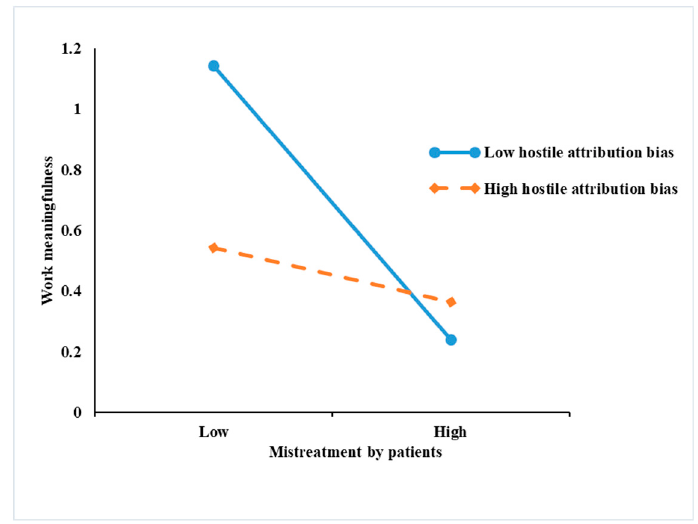
Figure 2. Interactive effects of mistreatment by patients and hostile attribution bias on work meaningfulness.